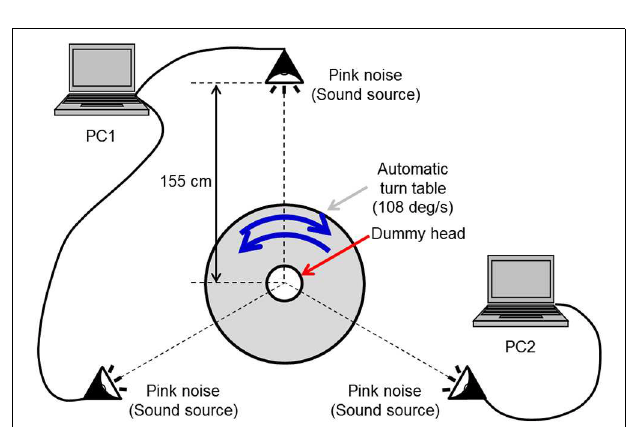
an upright position; (B) stationary random dot pattern (V_SRD); (C) horizontal one-directional motion (V_HOM); and (D) horizontal shearing motion between vertically adjacent stripe-shaped areas (V_HSM).